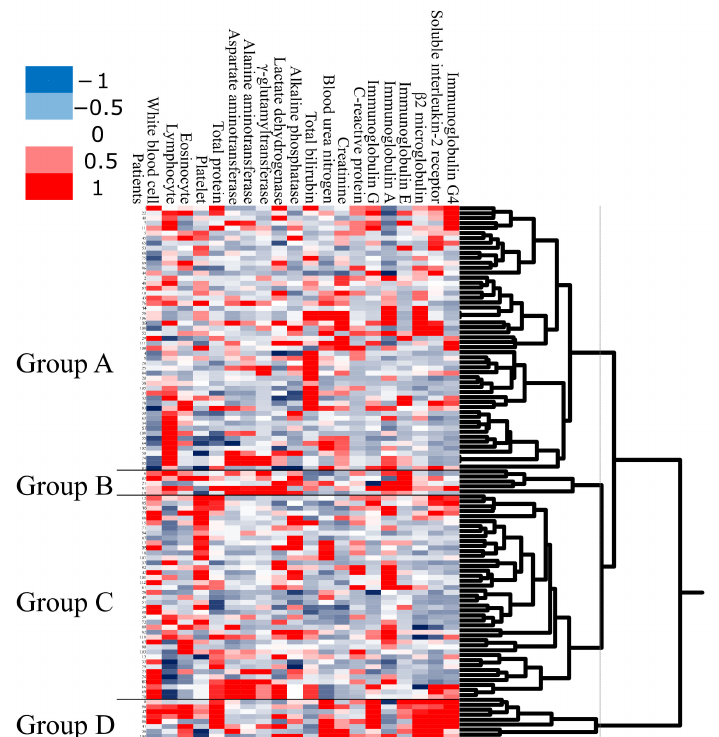
Figure 1. Patients are clustered into four groups by unsupervised hierarchical clustering analysis using the data of 20 peripheral blood tests. Group A, patients with low white blood cell (WBC) count; group B, patients with high serum immunoglobulin E (IgE); group C, patients with high Plt count; and group D, patients with high serum